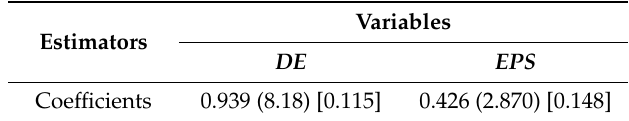
Table 4. Panel DOLS Long-run Estimates (Panel with Time